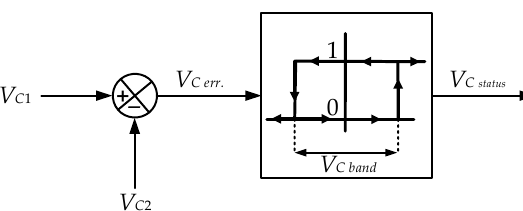
Figure 5. Hysteresis for the three-level NPC inverter balancing control.